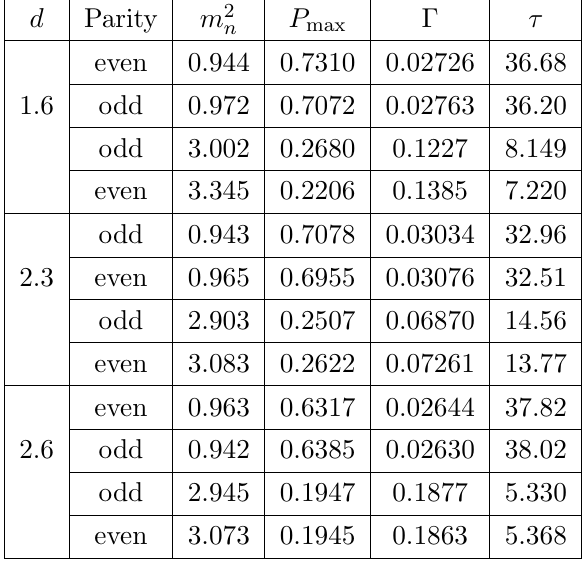
Table 3. The mass spectrum m 2 , relative probability P max , FWHM (cid:0) and life-time (cid:28) of a part n of the resonances quasi-localized on the sub-branes with di(cid:11)erent brane distance d for the double brane model